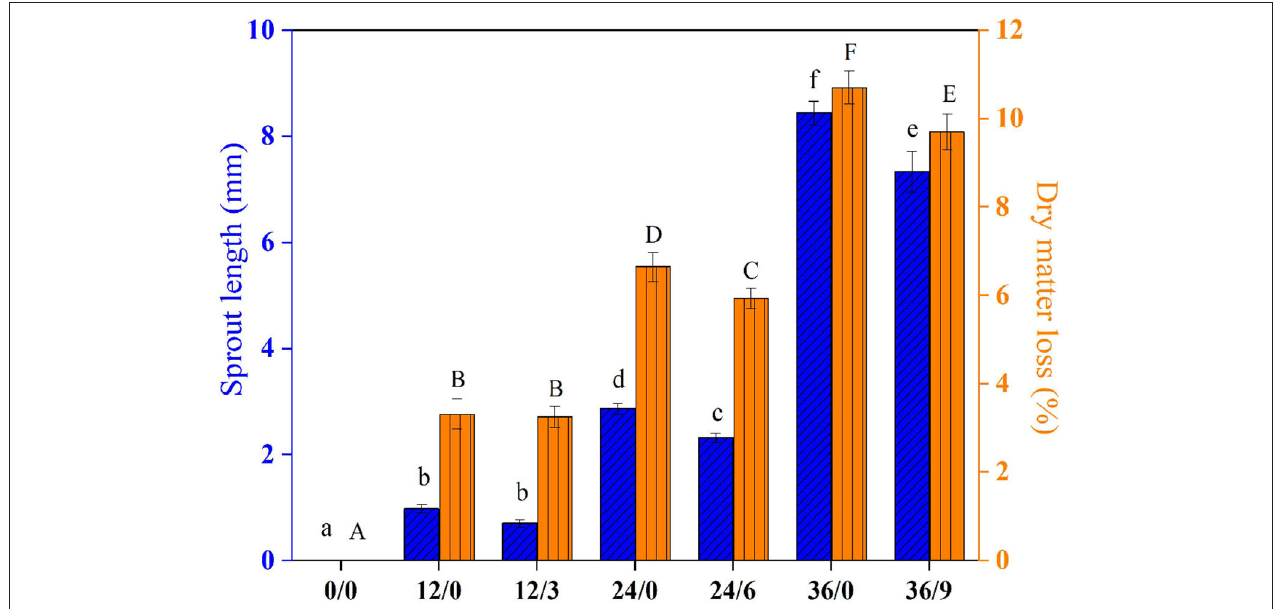
FIGURE 2 | The sprout length and dry matter loss of wheat during germination under UV-B radiation. Different letters indicate the results of Duncan’s multiple range test at 5% level of significant difference among different germination and UV-B radiation time,